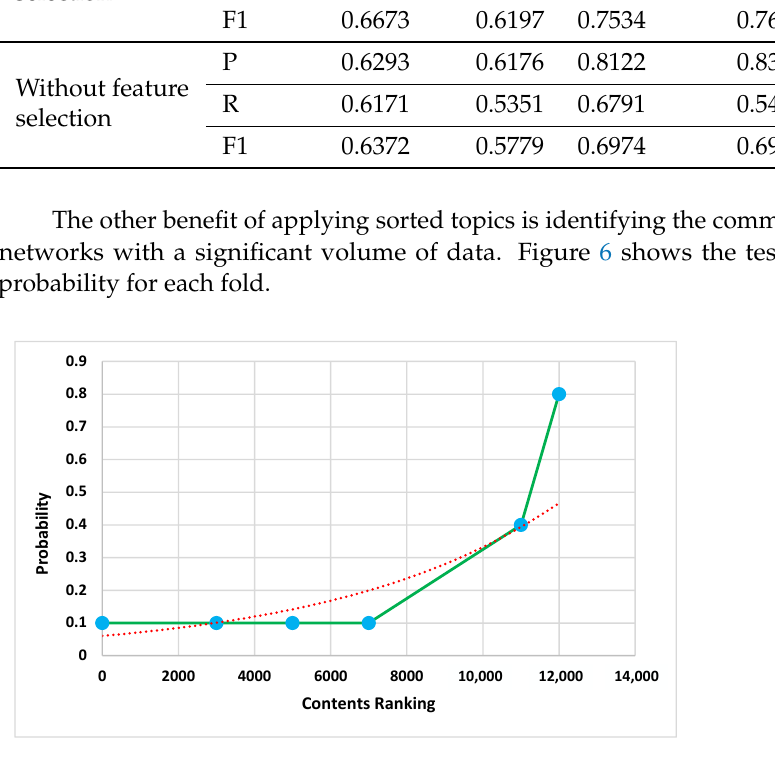
Figure 6. Topic probability analysis